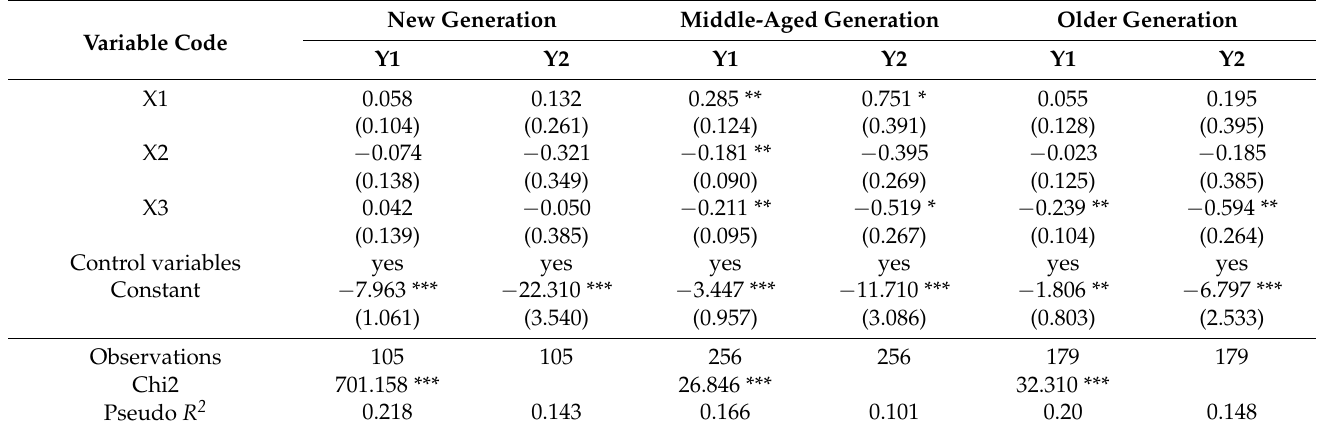
Table 5. The intergenerational difference of the impact of land attachment on land transfer.